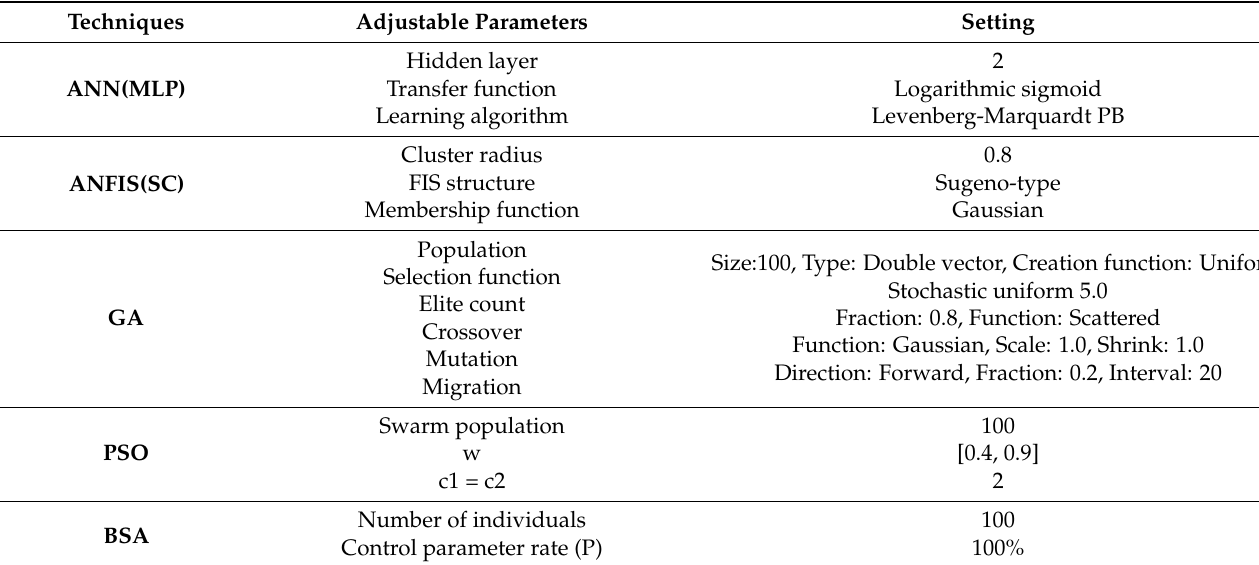
Table 4. User-defined parameters for applied techniques.